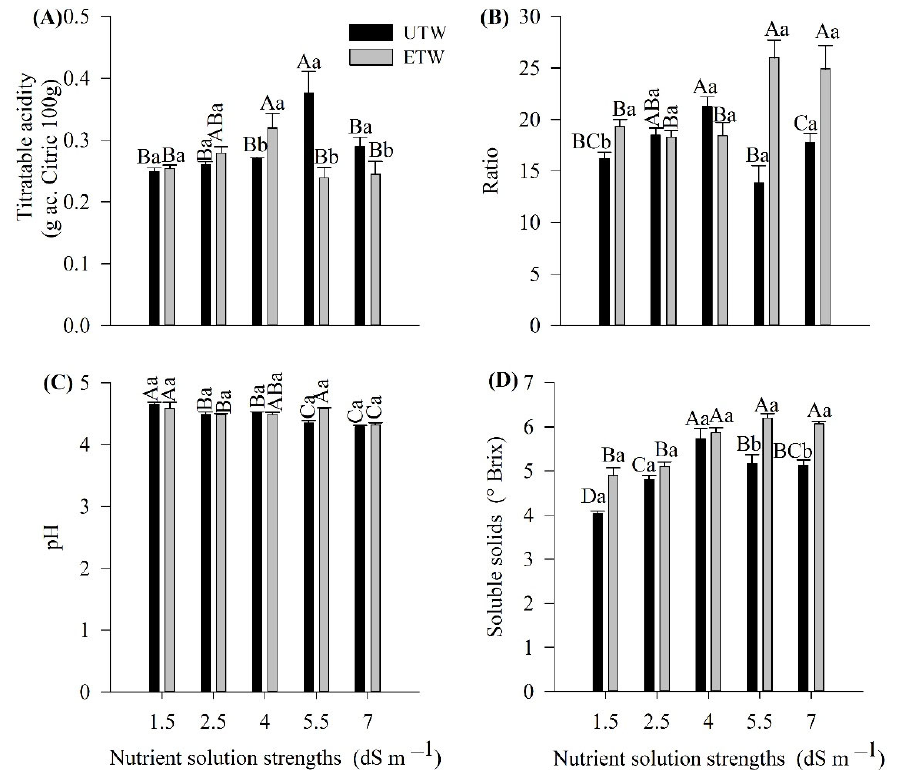
Figure 5. Physico-chemical characterization of the fruits of tomato cultivation subjected to different strength nutrient solution with electromagnetically treated water (ETW) and untreated water (UTW). ( A ) Tritratable Acidity, ( B ) Ratio, ( C ) pH and ( D ) Soluble solids. According to the Tukey test, the means followed by the same letter, lower case comparing the type of water, does not differ statistically ( p < 0.05). The error bars indicate the standard deviation of the average of four repetitions ( n = 4).